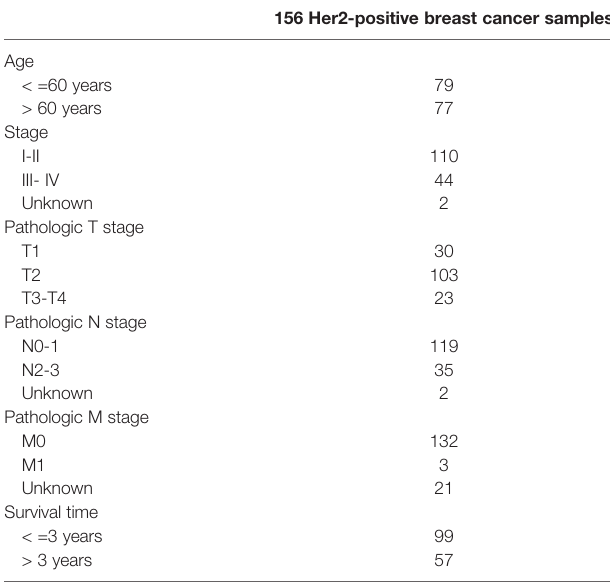
TABLE 3 | The speci fi c baseline clinicopathological characteristics of 156 Her2- positive breast cancer samples. 156 Her2-positive breast cancer samples